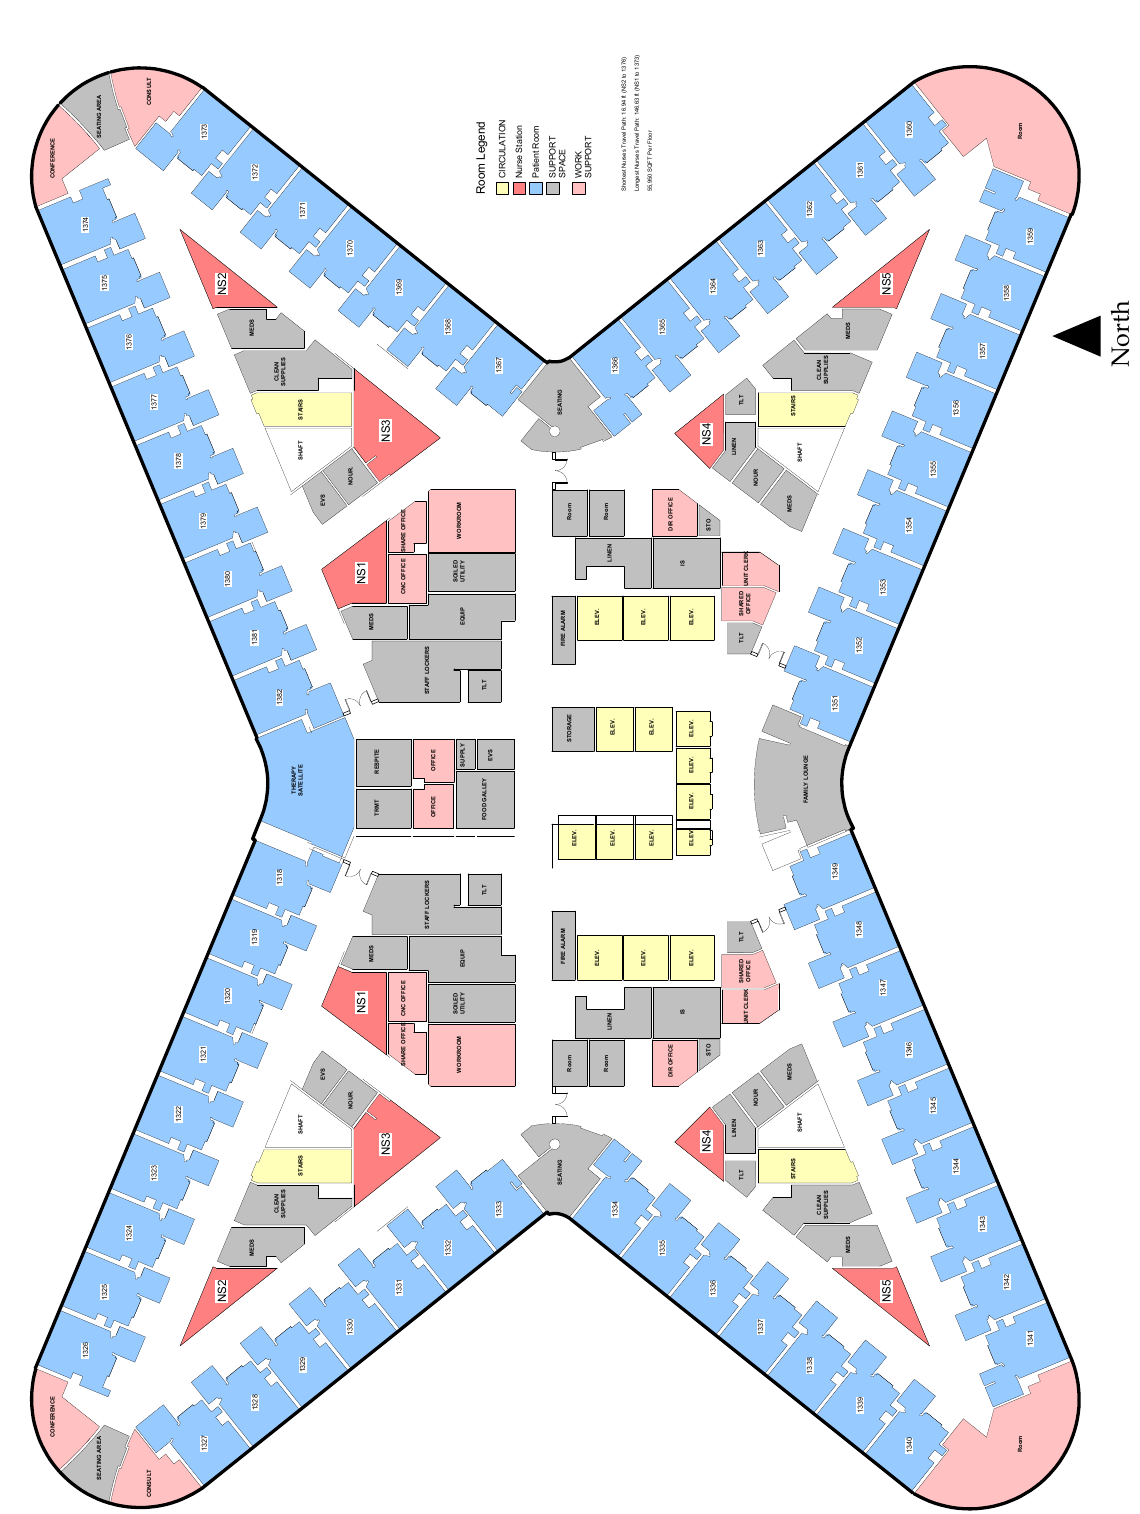
Figure A1. Floor plan of 13 East of new Tower (Image Courtesy: RUMC, designed by Perkins and Will, plan redrawn by the research team).